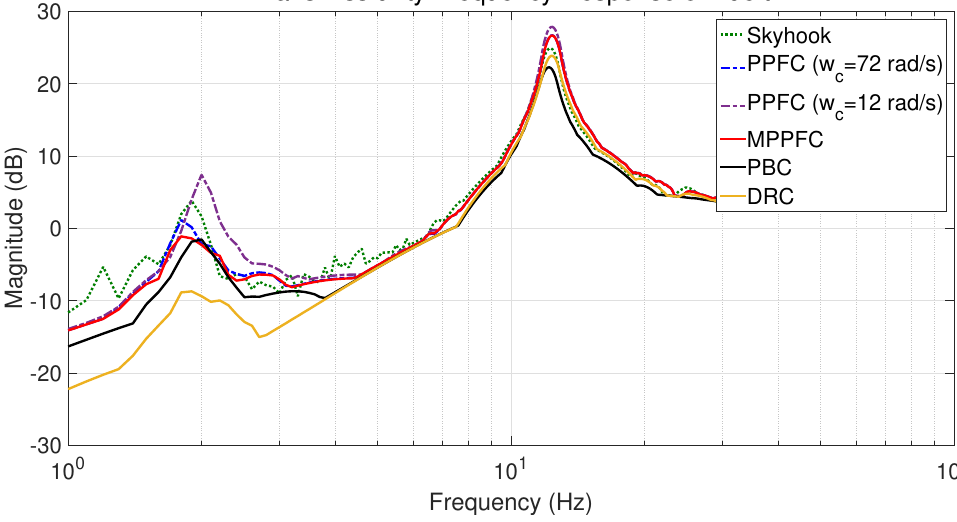
Figure 9. Comparison of TFR of the tyre deflection for different damping